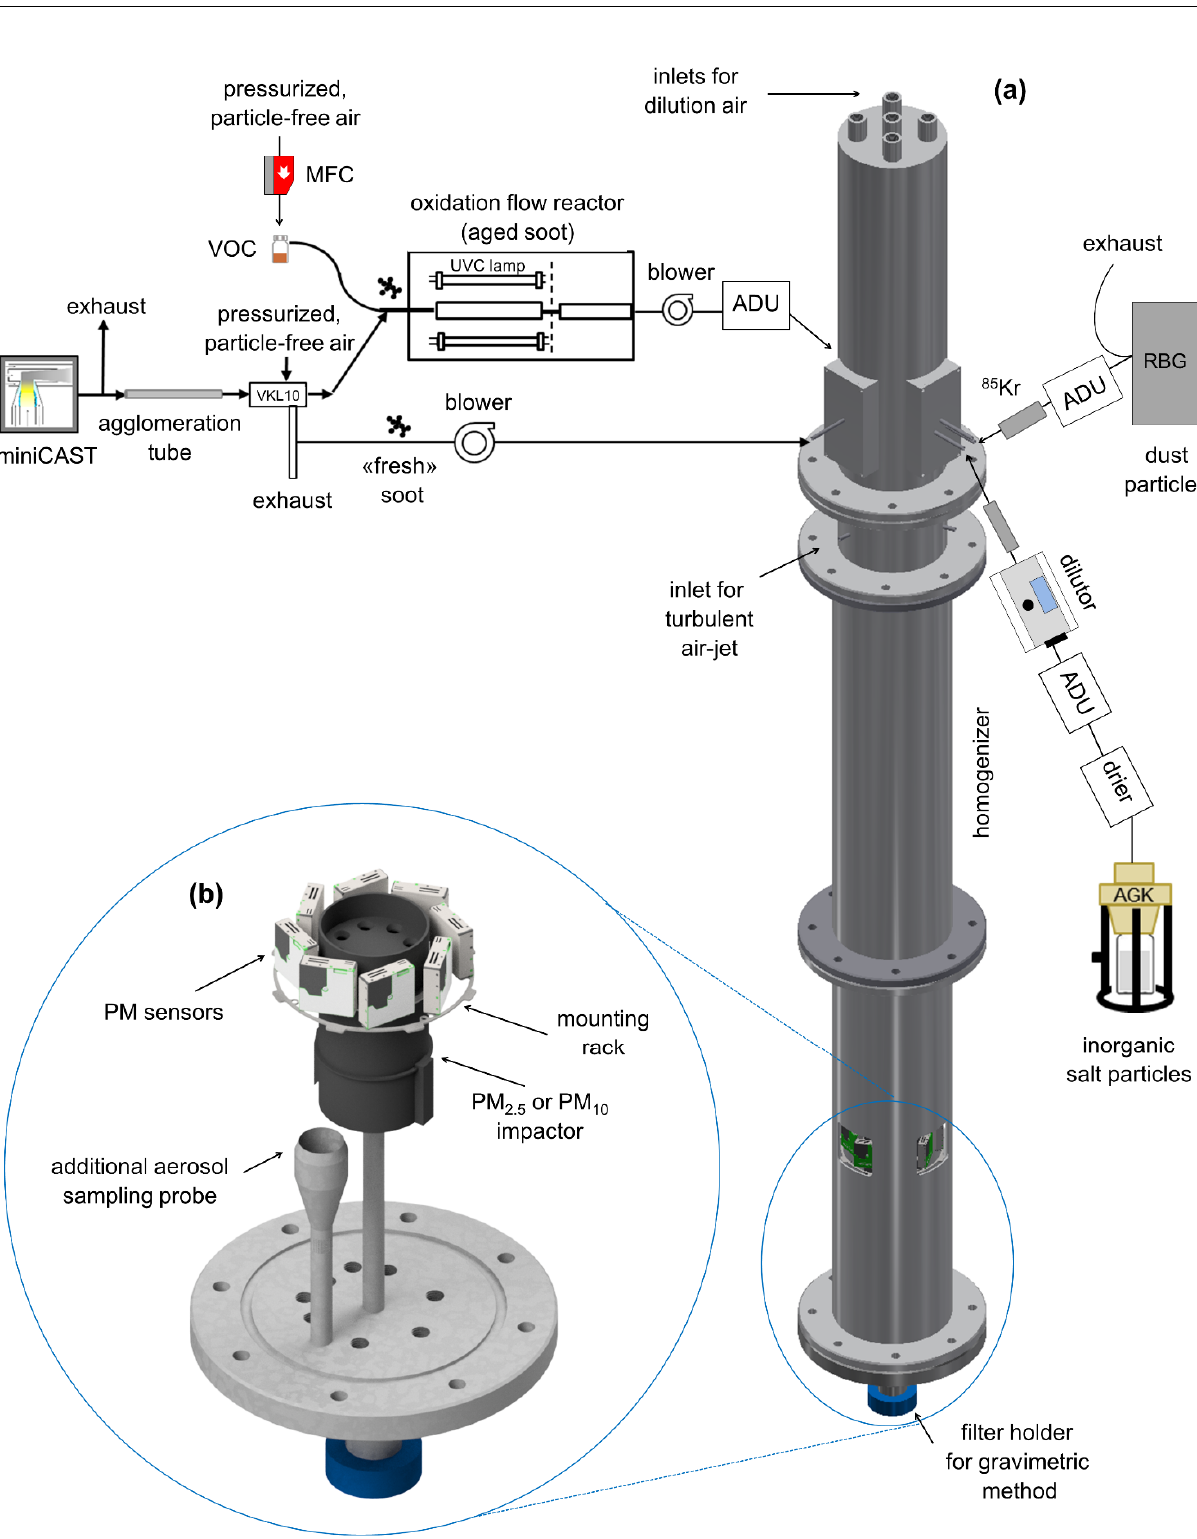
Figure 1. ( a ) CAD illustration of the homogenizer (see [20] for more information). ( b ) Enlarged view of the aerosol sampling system. An impactor selects PM 2.5 or PM 10 size fractions for the gravimetric reference method. The low-cost PM sensors are mounted on a rack surrounding the impactor. Aerosols can be also sampled through additional isokinetic sampling probes for further aerosol characterization. For simplicity, only one such probe is displayed. ADU: adjustable dilution unit (custom-made); VOC: volatile organic compound.